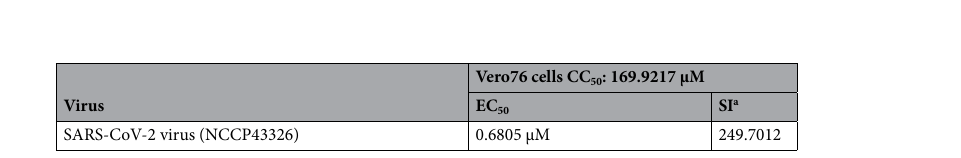
Table 1. Cytotoxic concentration (CC 50 ) and effective concentration (EC 50 ) of hemin in Vero76 cells against the SARS-CoV-2 strain NCCP43326. a SI: selectivity index (CC 50 /EC 50